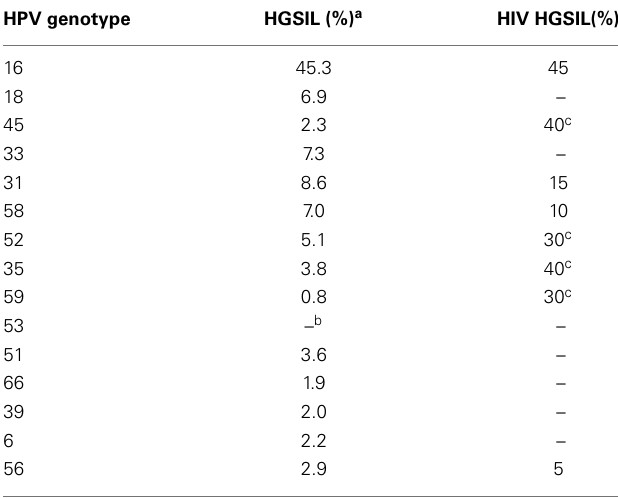
Table 5 | Human papillomavirus genotype prevalence (worldwide) in HGSIL compared to HIV + in Miami